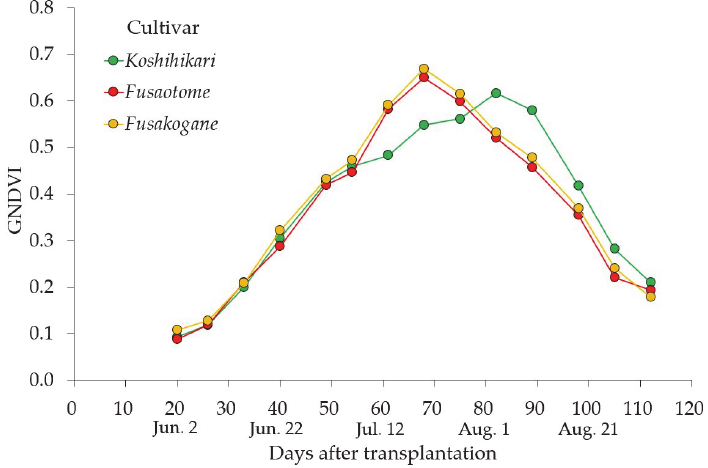
Figure 4. Time series of green normalized vegetation index (GNDVI) in the test site (2016). Green circles and the green line are Koshihikari , red circles and the red line are Fusaotome , and orange circles and the orange line are Fusakogane .